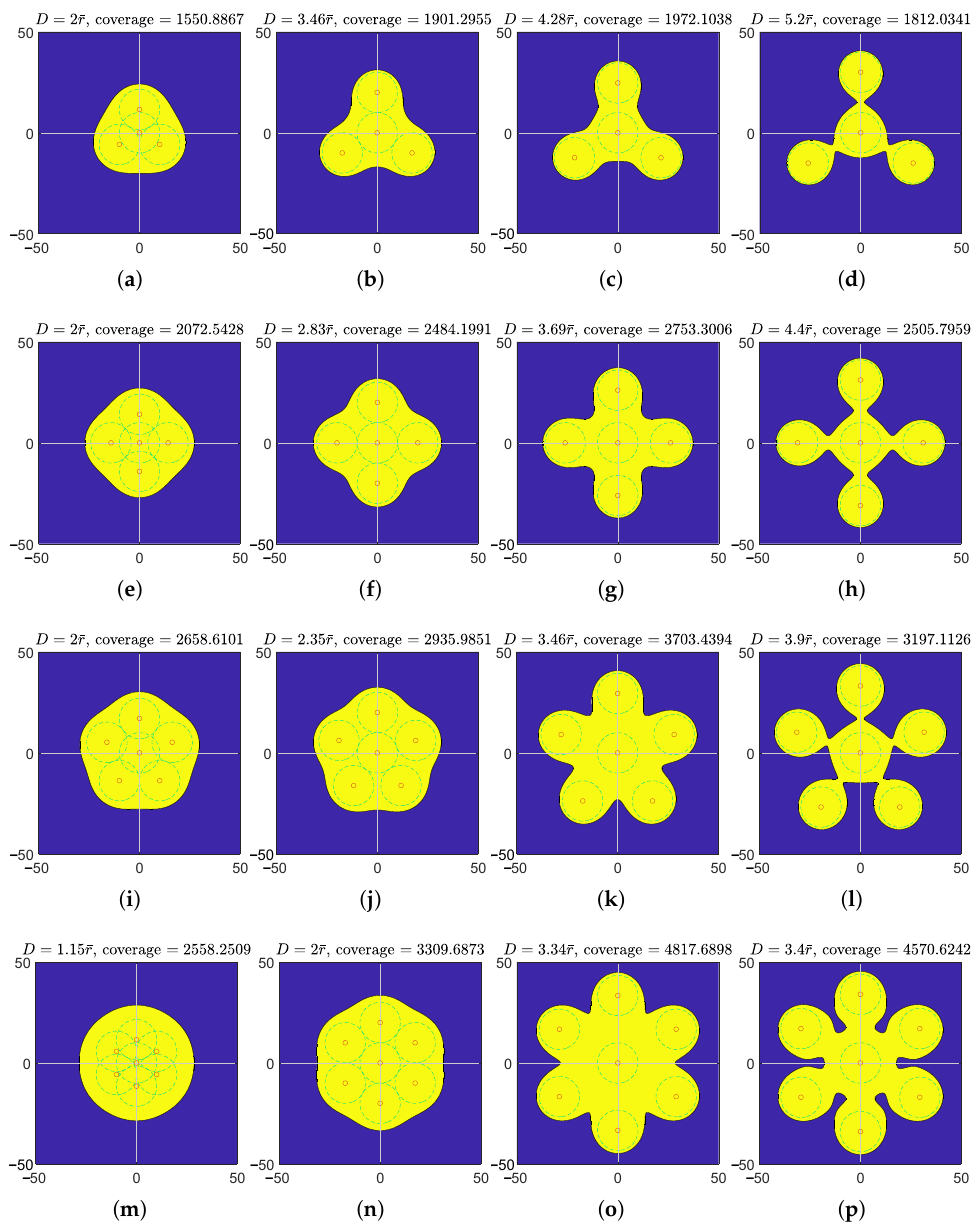
Figure 10. Illustration of effective coverages of n -node teams equipped with model I ( d ) = β / d 2 , where n = 4,5,6,7. The teams are in regular star formations. ¯ r = 10. Each row represents an n value. In the first column, individual effective coverage disks of every adjacent node pair are tangent in ( a , e , i ), and individual effective coverage disks of every other node on the polygon vertices are tangent in ( m ). In the second column ( b , f , j , n ), the individual effective coverage disks of nodes on the vertices are tangent to that of the center node. The third column ( c , g , k , o ) is the “max column”, where teams’ effective coverages are maximized. The fourth column ( d , h , l , p ) shows the effective coverages at randomly picked separations while the region is still